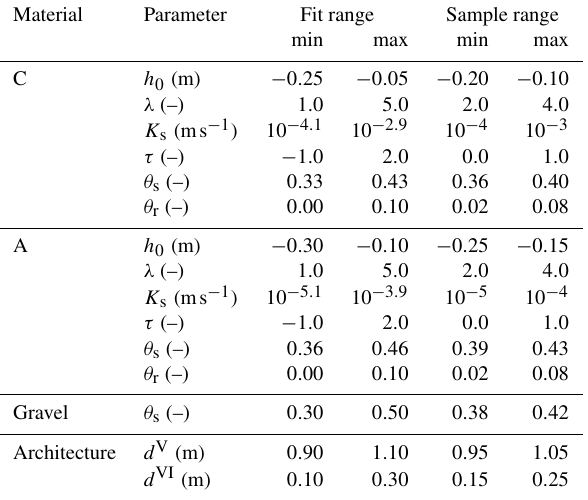
Table 1. The fit range limits the parameter space available for pa- rameter estimation and is in particular used by the simulated anneal- ing algorithm to draw parameter updates (Sect. 2.4.2). The sample range is used to generate an ensemble of initial parameter sets with a Latin hypercube algorithm.